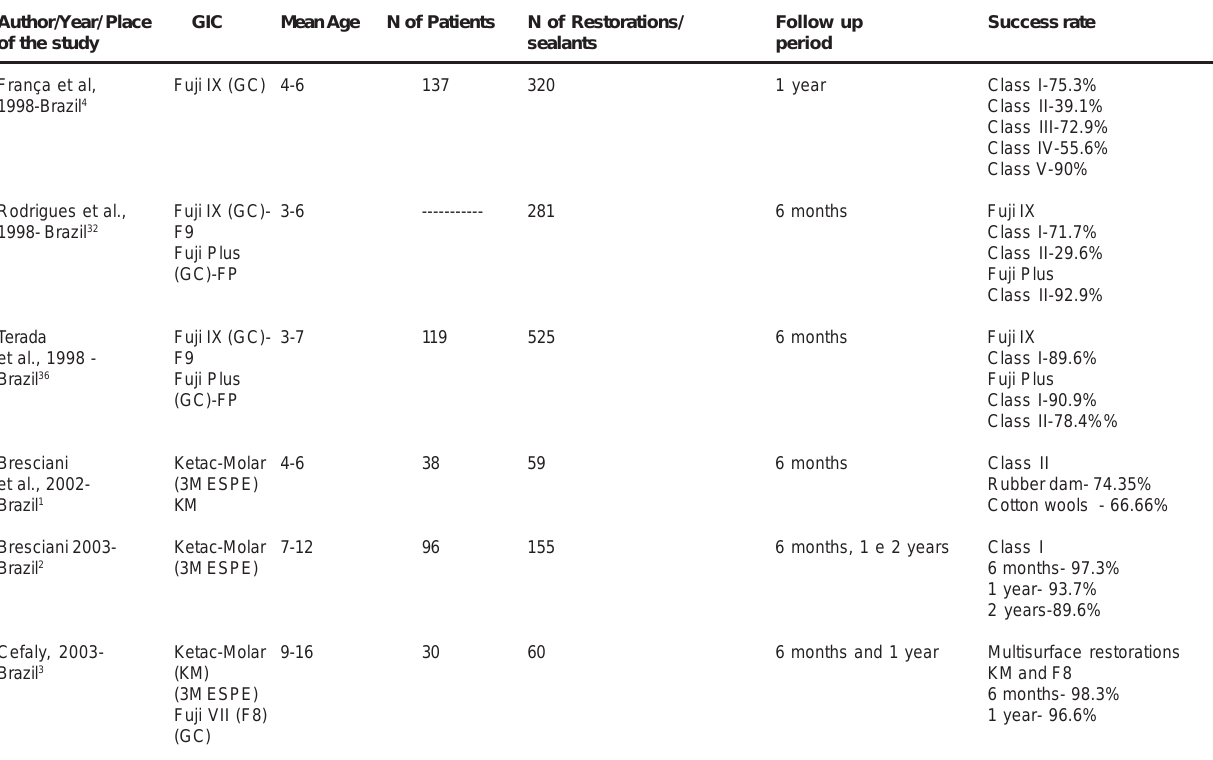
TABLE 3- Clinical Studies with ART performed at Bauru Dental